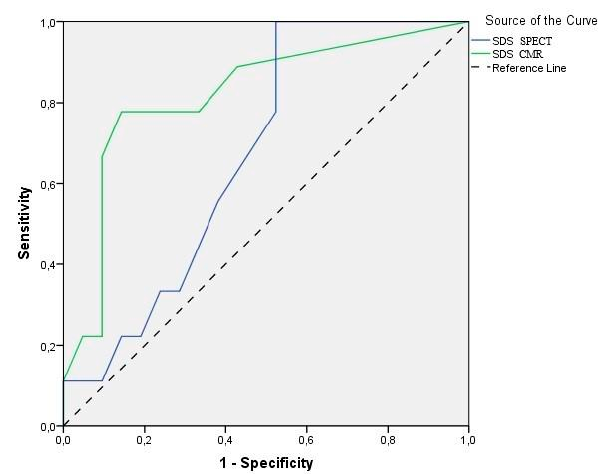
Figure 3. ROC curves of SDS (i.e., ability to detect stress-induced myocardial ischemia) for MPI by stress CMR and SPECT, as determined by coronary artery angiography ( ≥ 70% stenosis). The AUC was 0.82 for CMR and 0.67 for SPECT. Only CMR-determined ischemia had the ability to predict positive findings on coronary angiography ( p < 0.01).